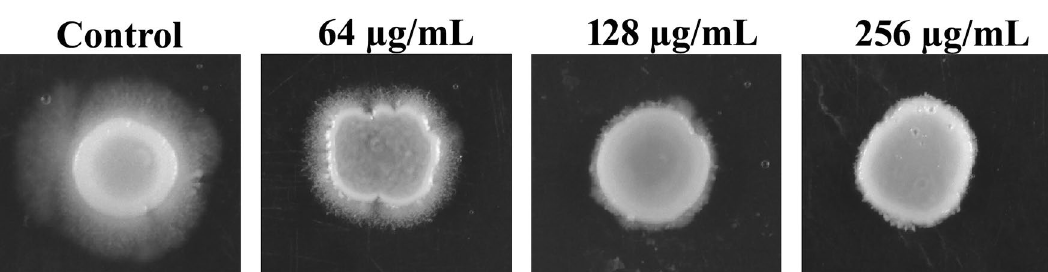
Figure 3. Conformation of yeast to hyphae inhibition by catechol on solid spider media. The fungal colonies were imaged after 5 days of incubation at 37° C. Colonies without catechol were bare the deep hyphal protrusion with irregular cell morphology whereas, colonies treated with catechol displayed a non-filamentous and very smooth